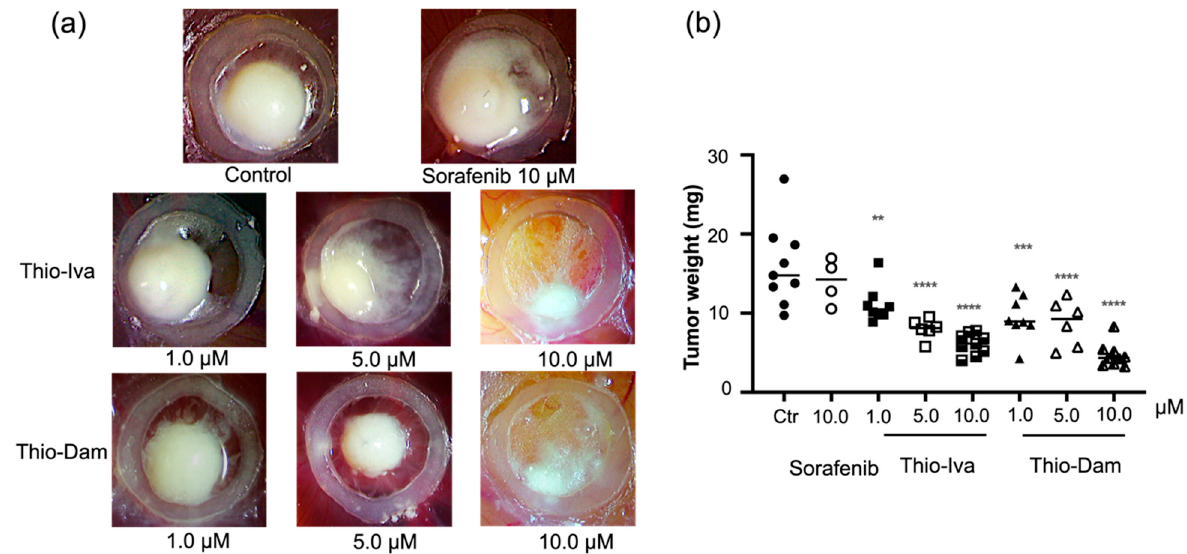
Figure 10. In vivo antineoplastic effects of Thio-Iva and Thio-Dam on Huh-7-derived HCC micro tumors. ( a ) Representative images of Thio-Iva and Thio-Dam-treated microtumors grown on the CAM of fertilized chicken eggs after 72 h. Sorafenib was additionally applied as a clinically relevant HCC therapeutic. PBS-treated microtumors served as controls. ( b ) Tumor weight analysis. ** p < 0.01, *** p < 0.001, and **** p < 0.0001 by ordinary one-way ANOVA compared to controls. Results are shown as means ± SEM of = 3 independent experiments.